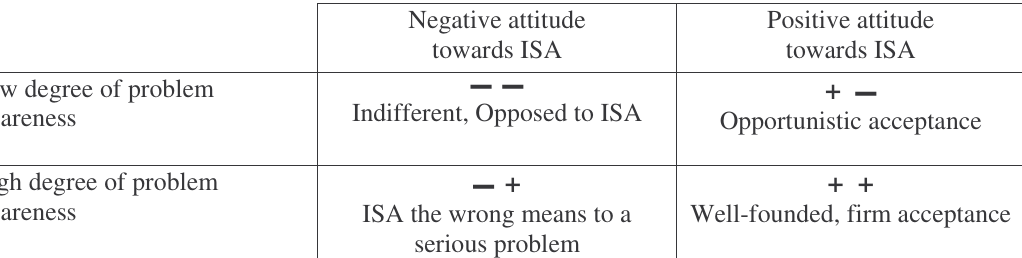
Figure 1. Types of acceptance in a multi-layered approach